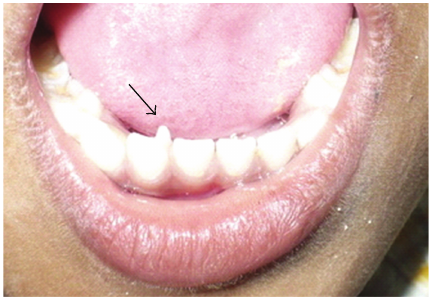
Figure 1: Talon cusp extending up to the incisal edge in 82.